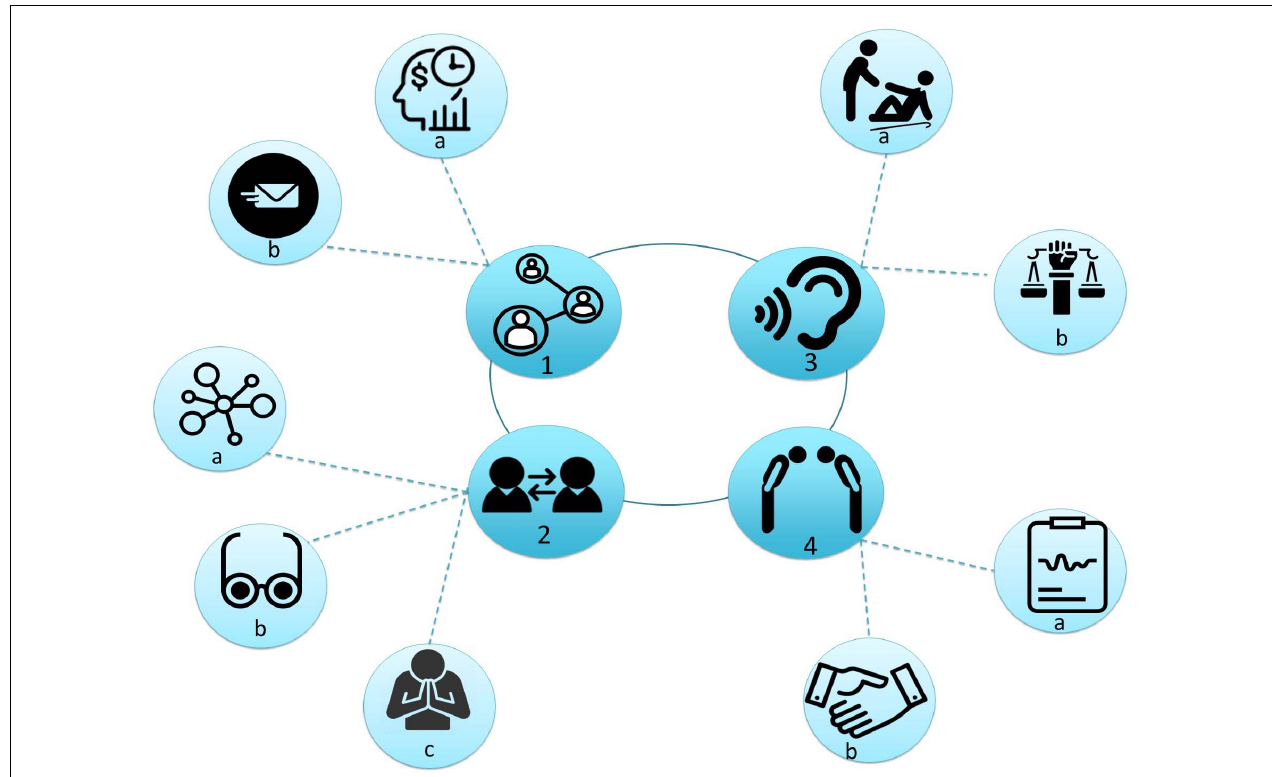
FIGURE 1 | Four insights from interdisciplinary researchers working with coastal communities. Insight 1 : Invest in rapport by planning to (a) dedicate enough time to communities and (b) keeping in touch with them. Insight 2 : Engage and exchange: (a) invest in networking, (b) be open to new points of view and sources of knowledge, (c) be humble. Insight 3 : Be accommodating and attentive to communities’ aspirations by (a) leaving no one behind and (b) avoiding creating mechanisms that promote power grabbing or imbalance. Insight 4 : Be respectful by (a) not treating communities as a simple means to test scientific hypotheses and (b) by promising them only what can be reasonably